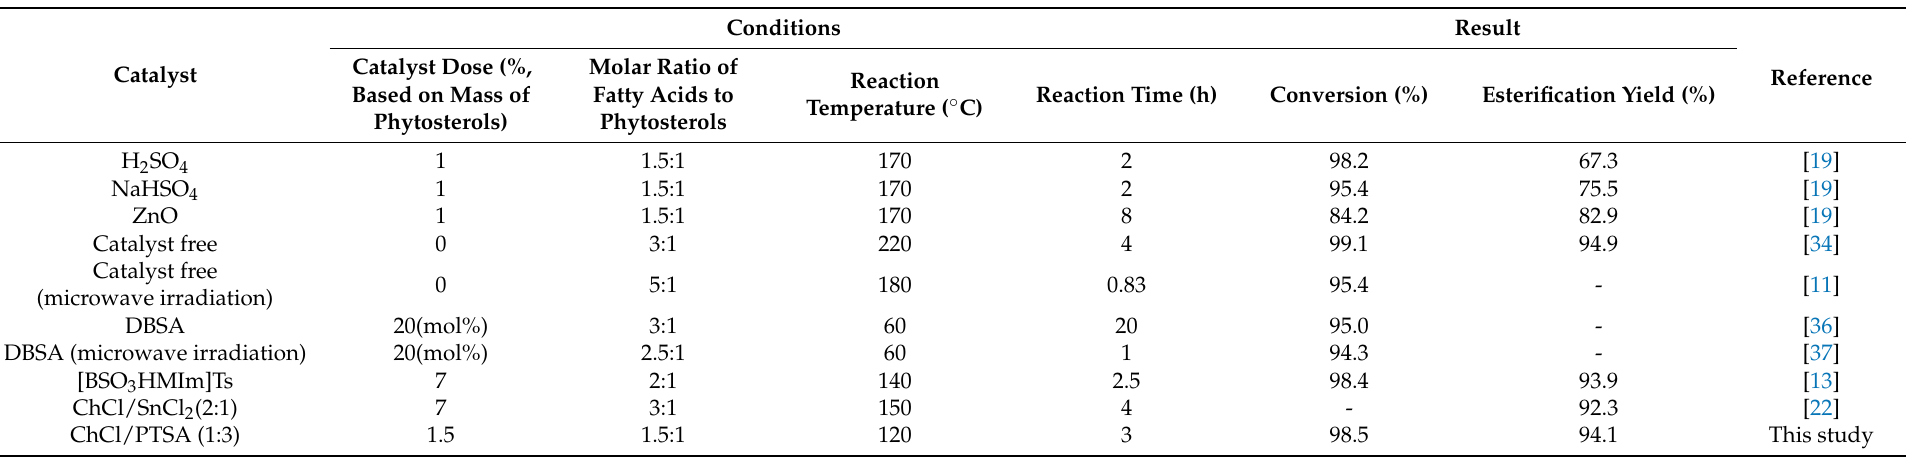
Table 3. The reaction conditions and results of different reported chemical syntheses of phytosterol